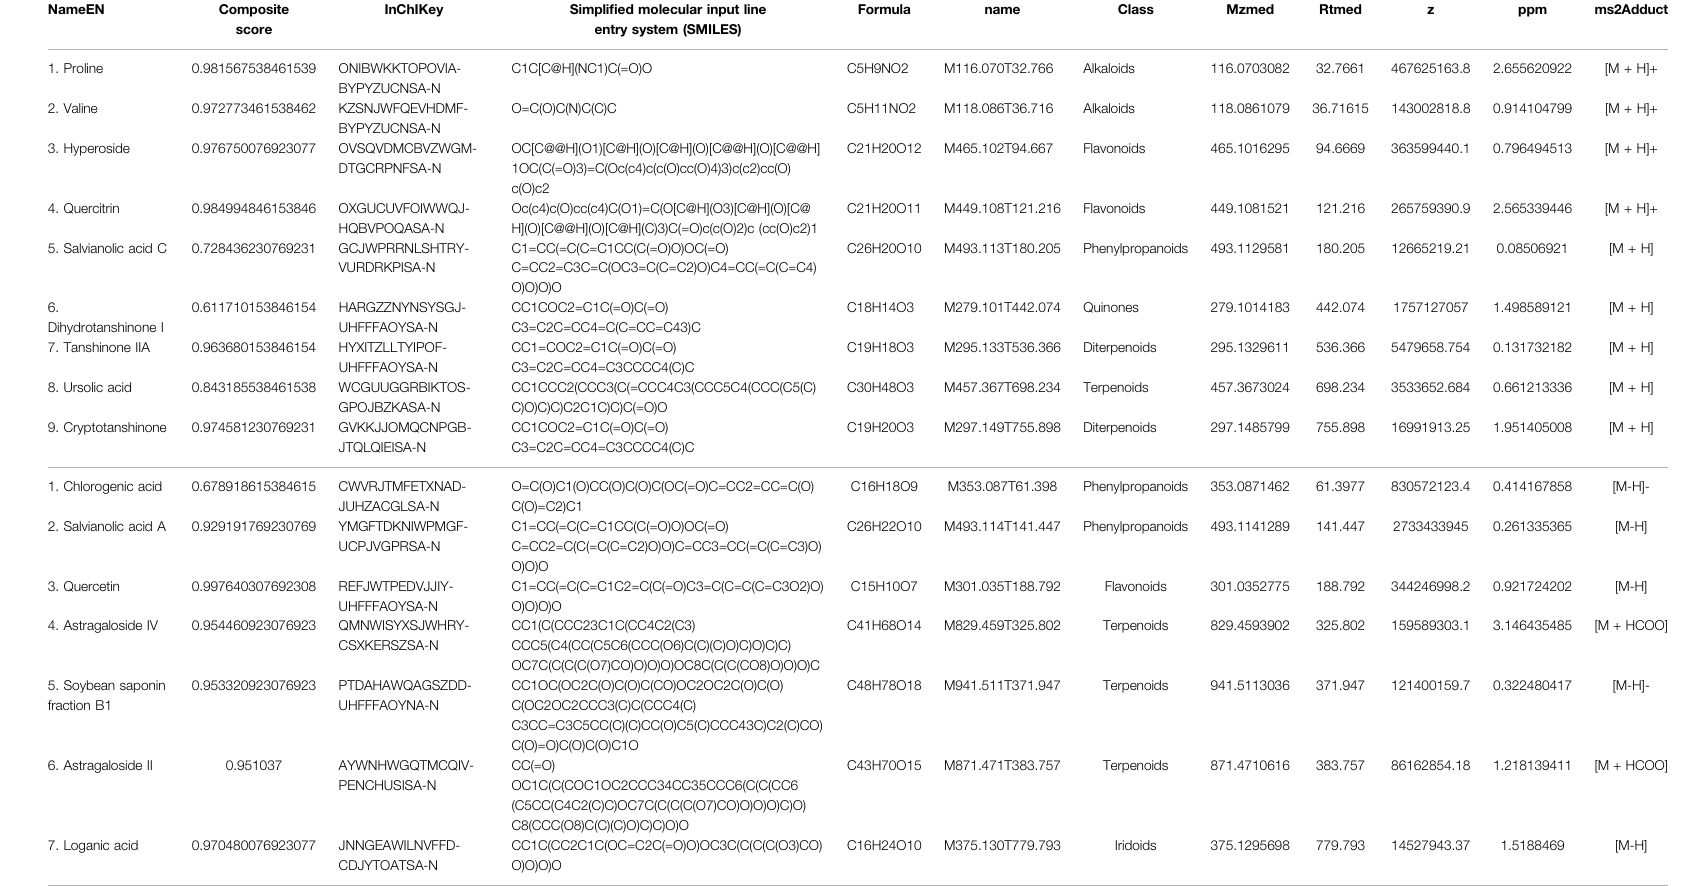
TABLE 2 | The identi fi cation of chemical constituents of BSHXD by UHPLC-QE-MS. (A) The positive ion mode. (B) The negative ion